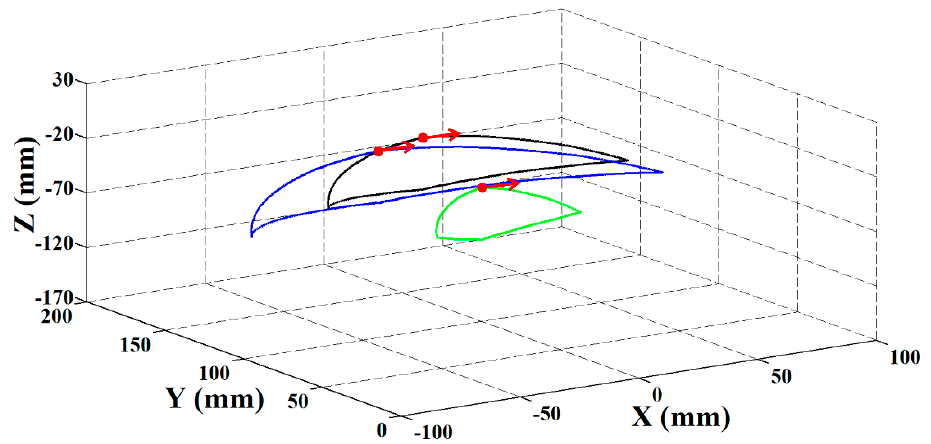
Figure 5. The trajectory curves of points e , f and c . The blue, green and black lines represent the curves of points f , e , and c , respectively. The red points and arrows, respectively, are the initial positions and initial directions of the points.